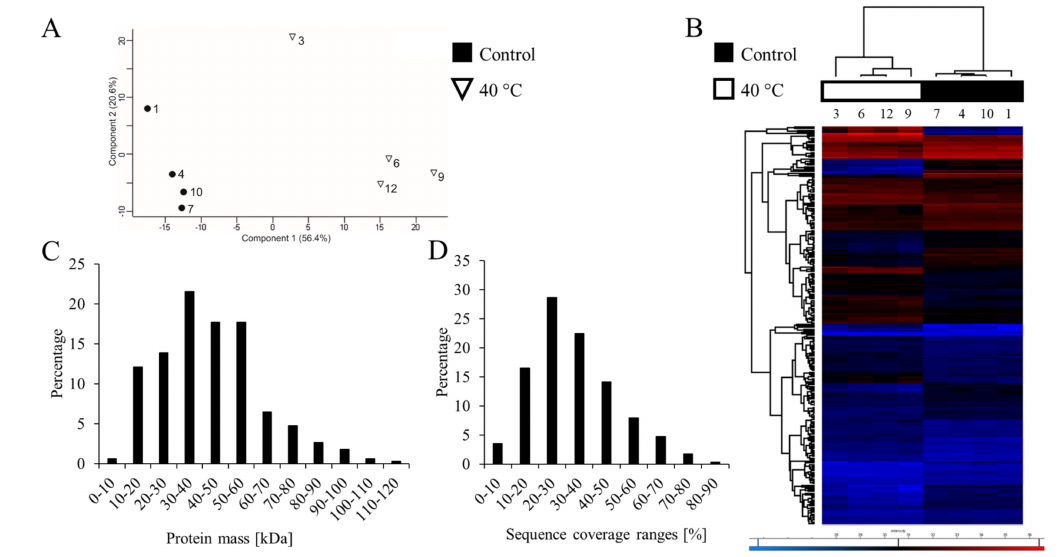
Figure 1. General features of the proteomic analysis. ( A ) Principal component analysis scatterplot in which each point represents a biological replicate. ( B ) The hierarchical clustering of the differentially abundant proteins (DAPs) that were identified in the experiment. ( C ) The molecular mass distribution of the proteins. The X-axis represents the theoretical molecular mass (kDa); the Y-axis represents the percentage of CWPs within each mass range. ( D ) Sequence coverage distribution for the identified proteins. The X-axis represents the sequence coverage ranges; the Y-axis represents the percentage of CWPs within each sequence coverage